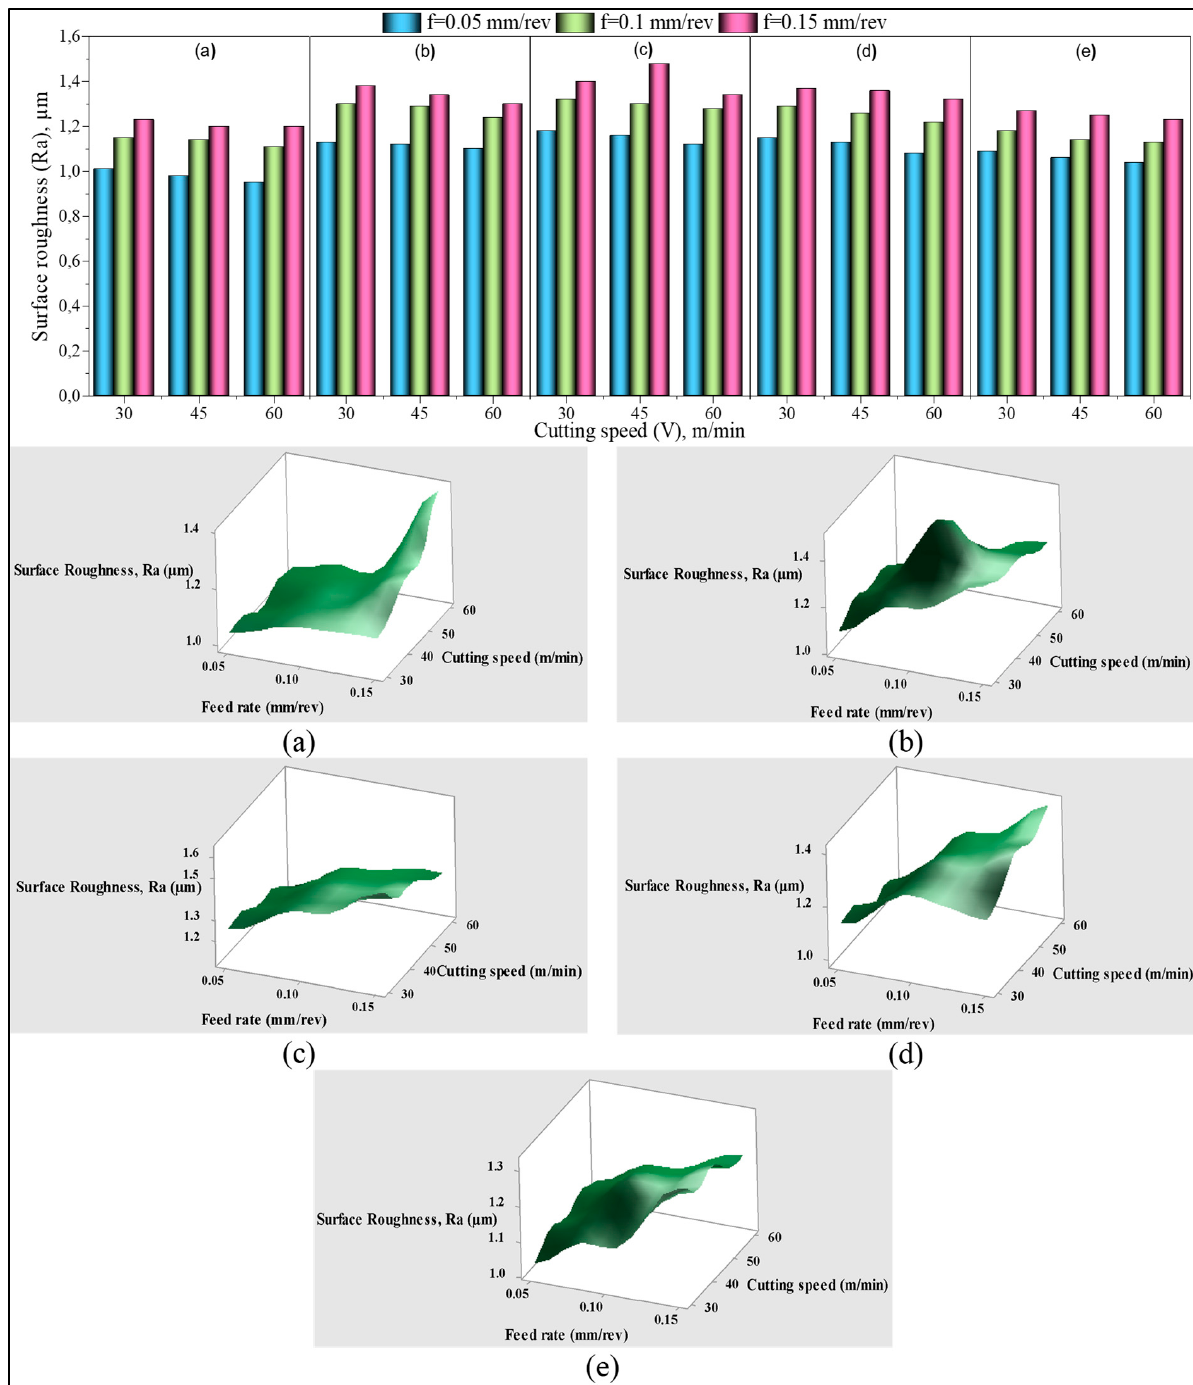
Figure 5. Surface roughness (Ra) variation versus drilling parameters with 2D bar and 3D surface plots: ( a ) C1, ( b ) C2, ( c ) C3, ( d ) C4, ( e ) C5.